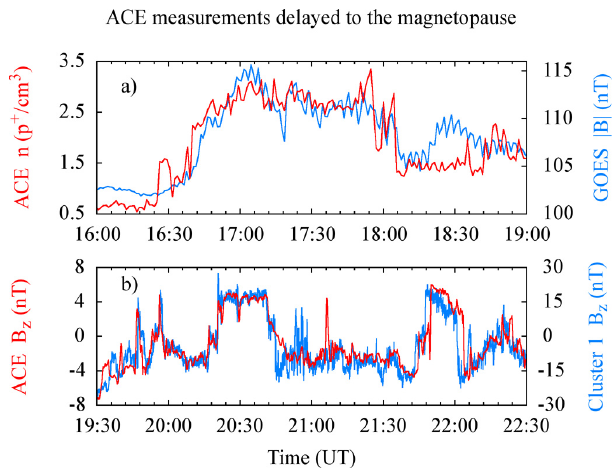
Fig. 3. The solar wind n and B z from ACE delayed by about 45 and 46min over n from GOES-12 and B z from Cluster 1, respectively. Note that the panels are displayed at different times.